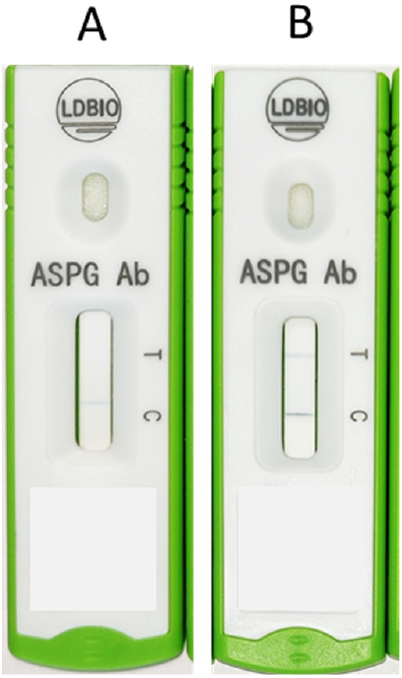
Figure 3. Pictorial representation of LDBio assay results: ( A ) negative, ( B ) positive.